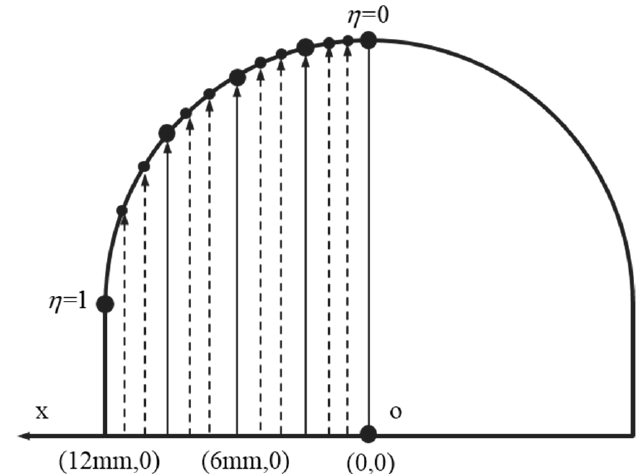
Figure 9. Impact point distribution.